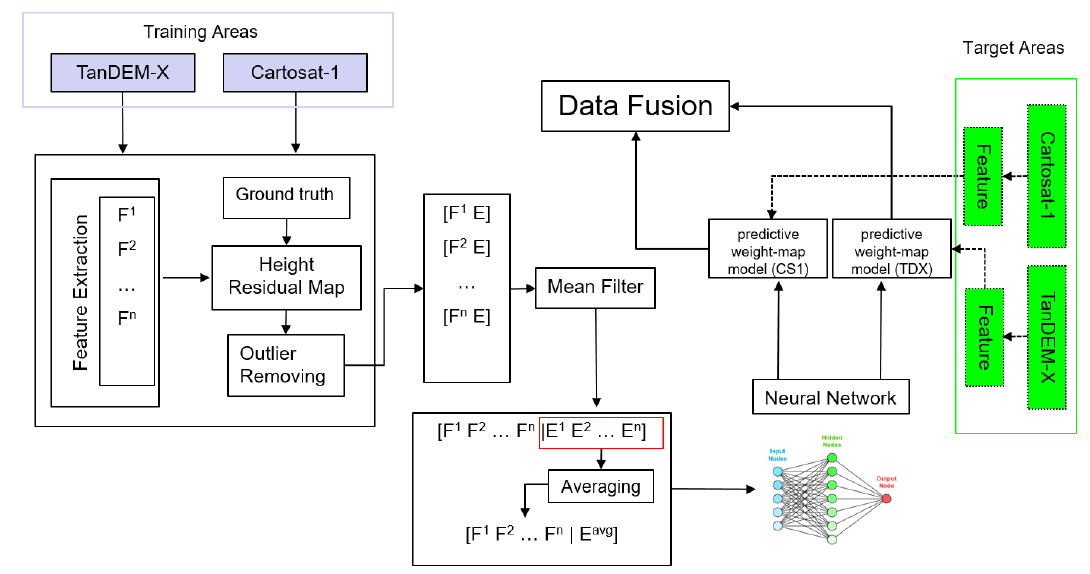
Figure 1. The proposed framework for ANN-based weight map model generation for fusion of TanDEM-X and Cartosat-1 DEMs